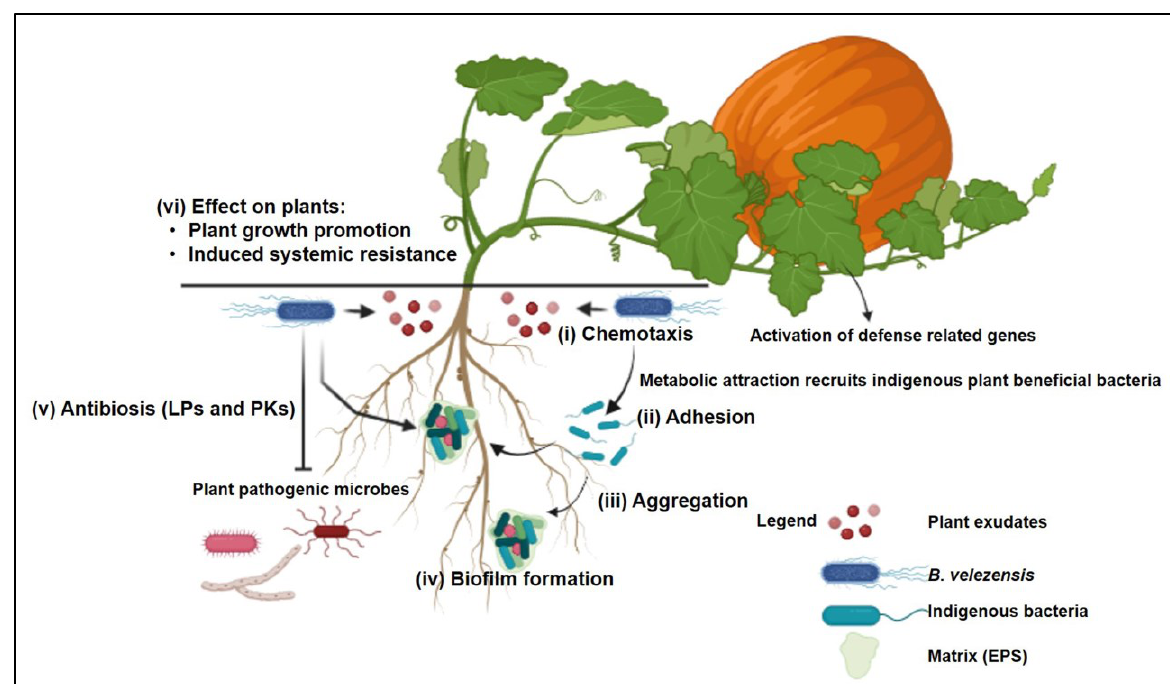
Figure 3. Sequential events that take place in the rhizosphere following the application of biocontrol agent B. velezensis . Root colonization of B. velezensis through (i) chemotaxis, (ii) adhesion, (iii) aggregation, and (iv) biofilm formation. LP- and PK-type compounds synthesized by B. velezensis have an effect on pathogenic microbes in the rhizosphere (v) and overall plant growth promotion and defense response of the plants increased (vi).